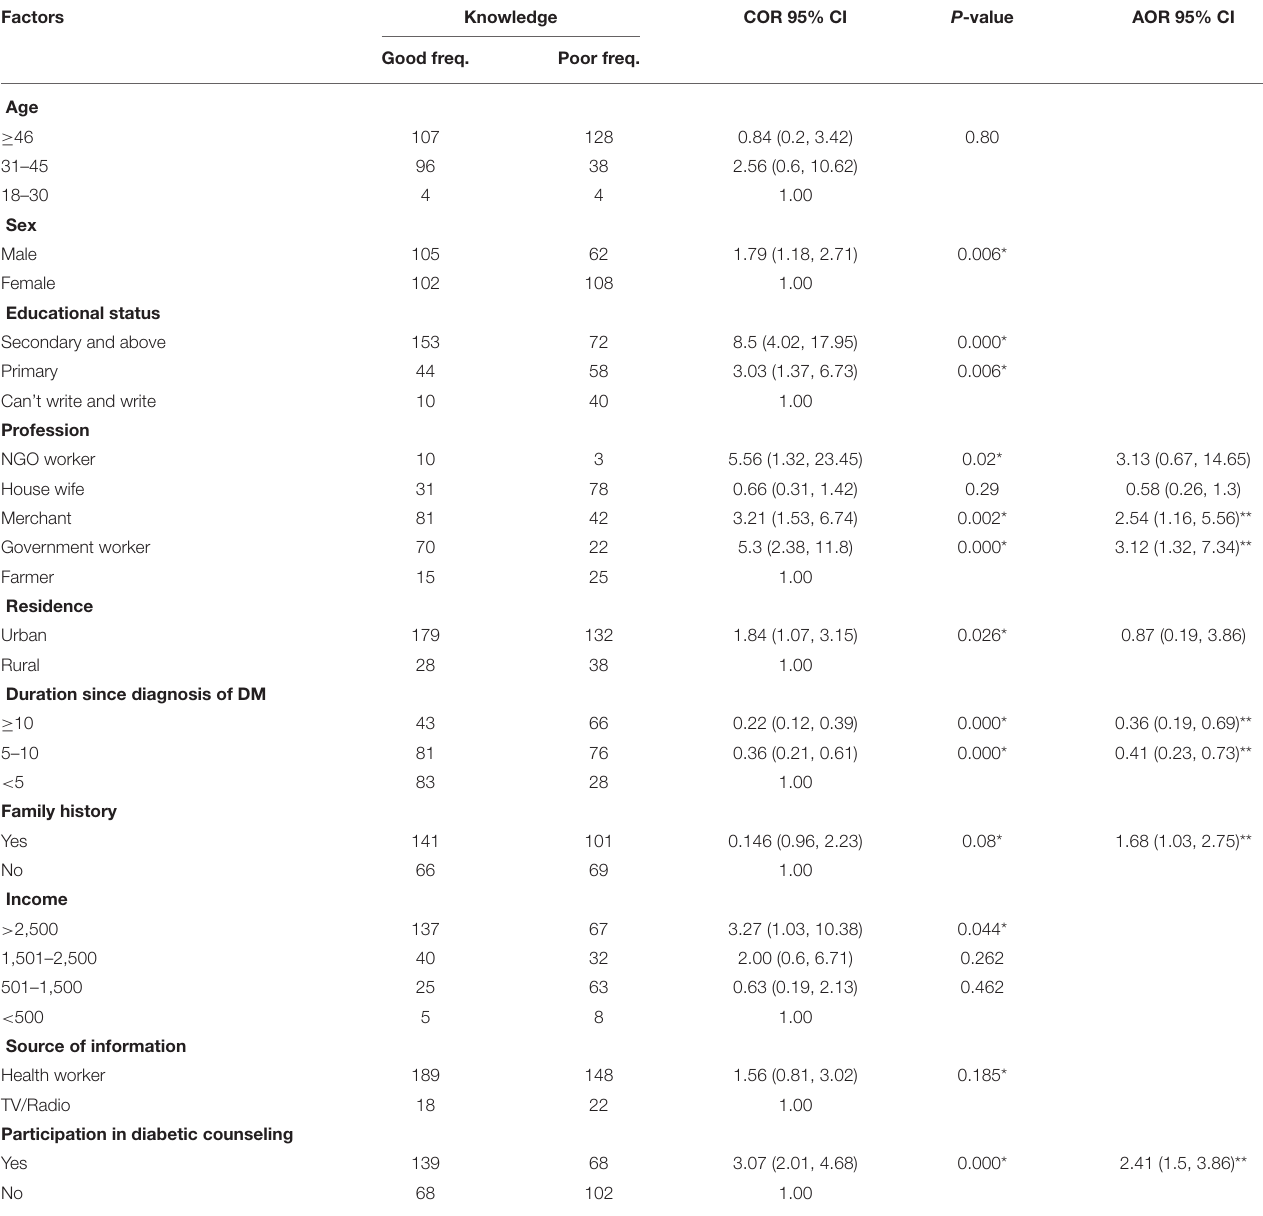
TABLE 4 | Bivariate and multivariable logistic regression analysis of knowledge of diabetes mellitus complications among Type-2 diabetic patients in public hospitals of Addis Ababa, 2020. Factors